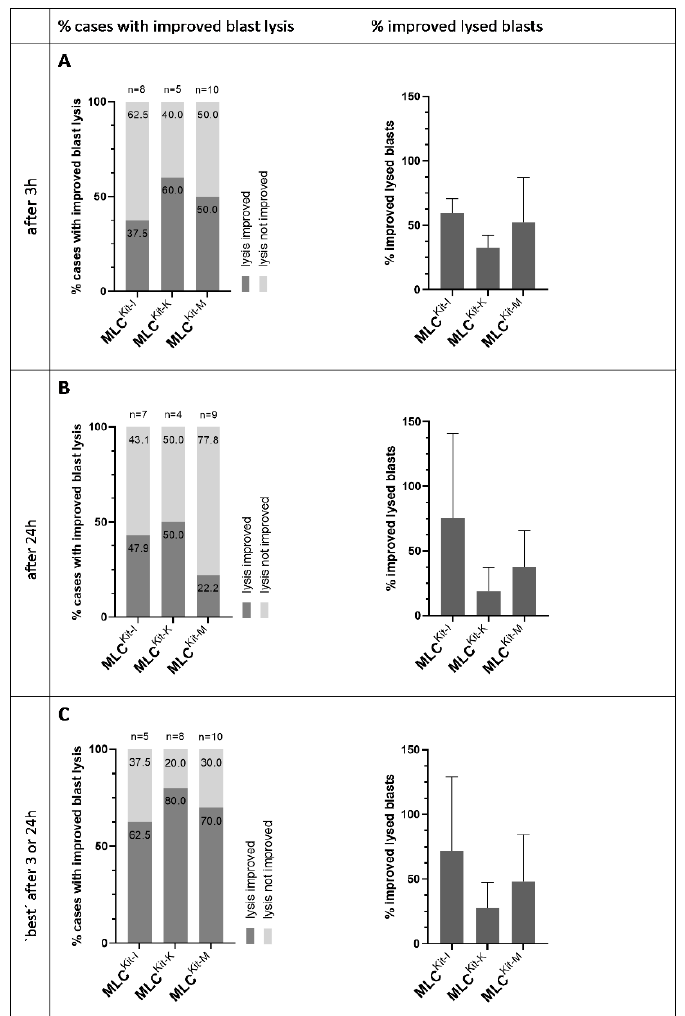
Figure 8. Stimulatory impact of DC/DC leu generated with Kit-I, -K and -M on the anti-leukaemic cytotoxicity of T cell enriched immunoreactive cells. Given are the proportion of cases with an im- provement in blast lysis (“% cases with improved blast lysis”) and the mean ± SD of improved lysed blasts (“% improved lysed blasts”) in MLC Kit-I , MLC Kit-K and MLC Kit-M in relation to MLC Control after 3 h ( A ) and 24 h ( B ), and the “best” achieved results after 3 h and 24 h ( C ).